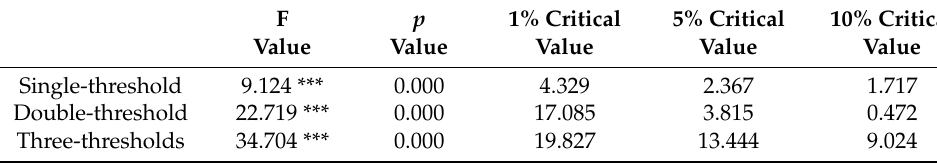
Table 7. Threshold effect test: From the perspective of green innovation efficiency.